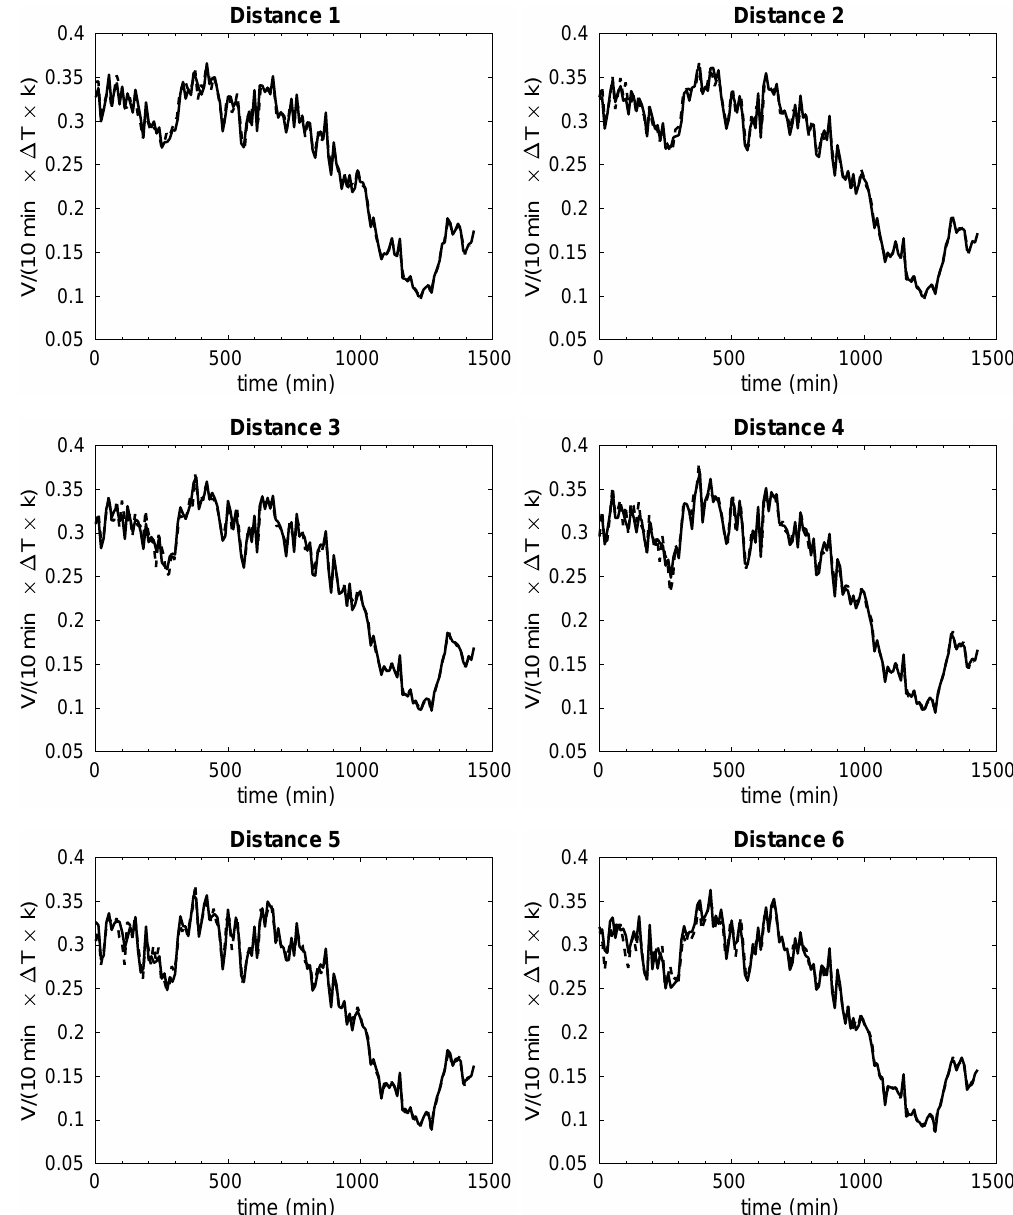
Figure 9. Counterpart of Figure 8 for the left set of